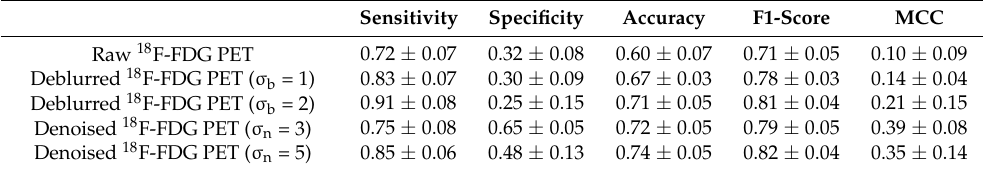
Table 2. Performance comparison of an individual classification model trained by raw, denoised, or deblurred whole-brain 18 F-FDG PET images for the classification of Alzheimer’s disease and cognitively normal